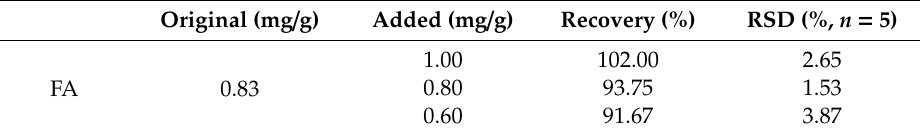
Table 2. Recoveries of Ferulic Acid (FA) in Spiked Sample 1.